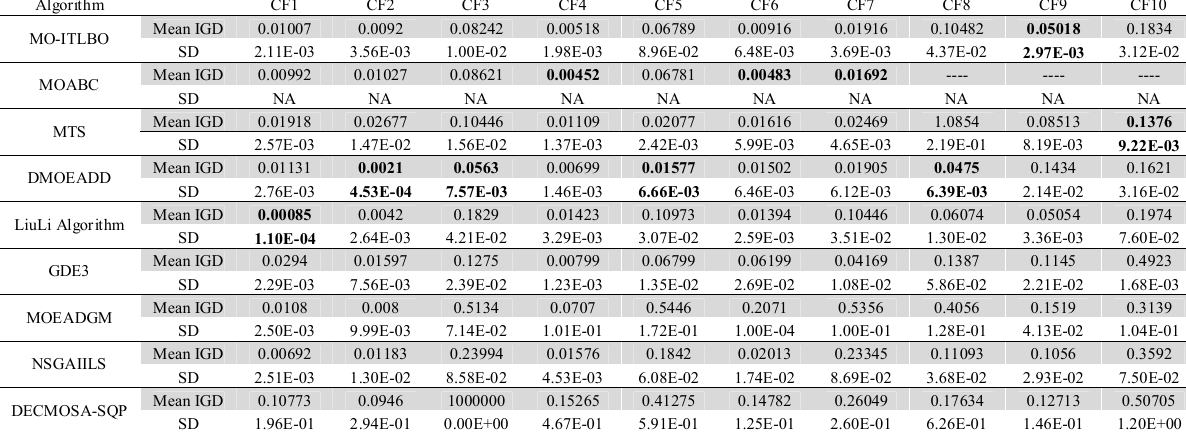
Comparison of mean IGD values and standard deviation (SD) obtained with different algorithms for different constrained test functions (CF1-CF10) in 30 independent